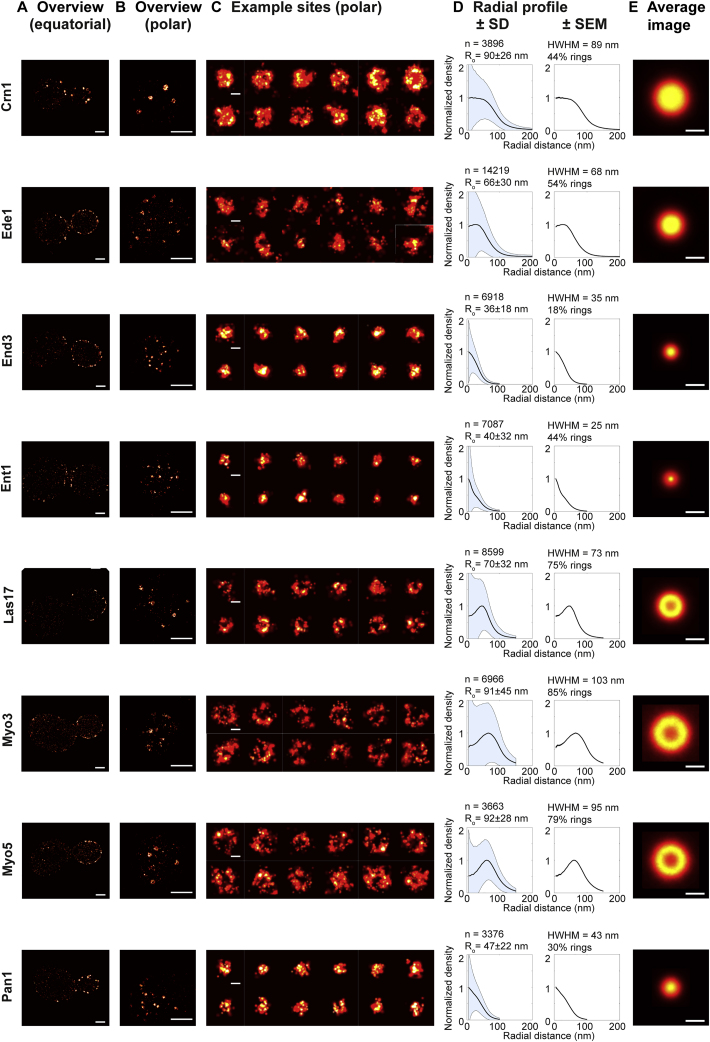
Overview of Imaged Endocytic Proteins (Part 2/3), Related to Figures 1 and 2(A–E) As in Figure S1. Scale bars 1 μm (A and B) or 100 nm (C and E).